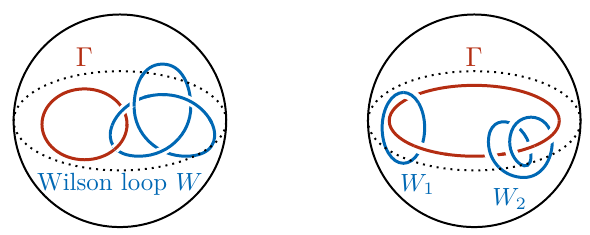
Figure 7 . The intersections between the entangling surface Γ and the Wilson loops. The left panel describes the setup with n (Γ ∪ W ) = 1 . In the right panel, we count it as n (Γ ∪ W ) = 2